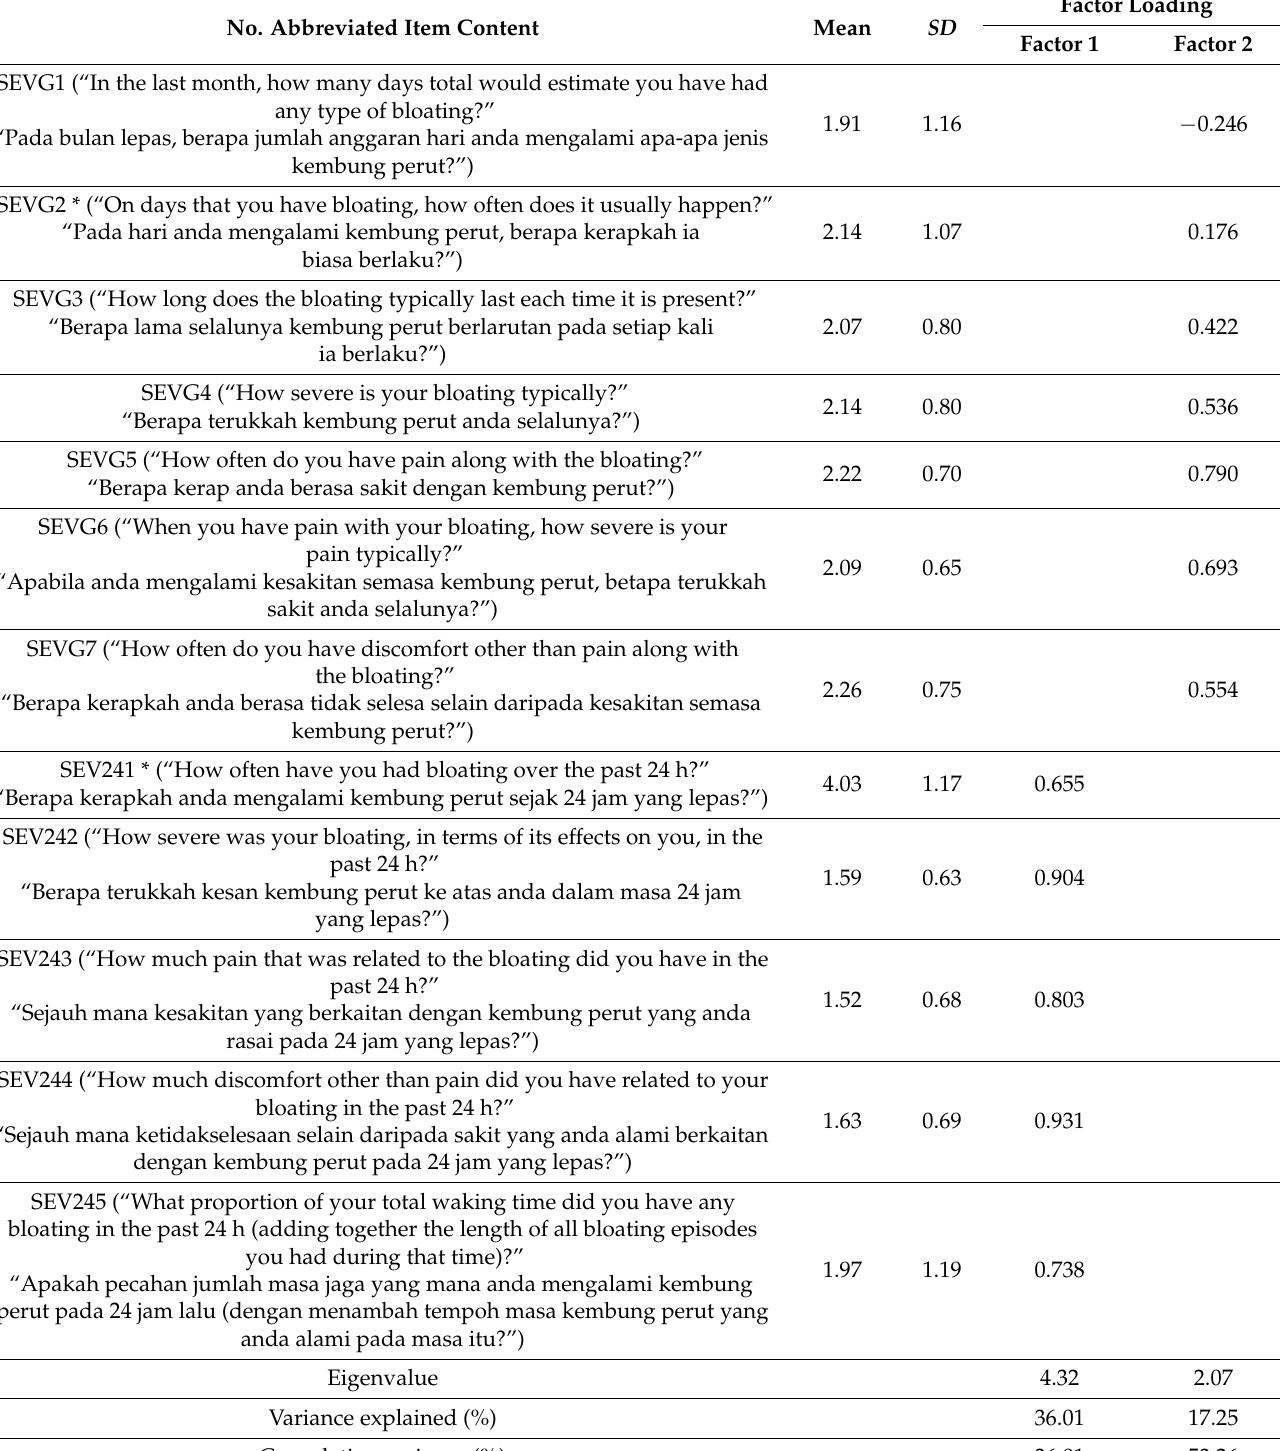
Table 1. Descriptive statistics for severity general and severity 24 h ( n =